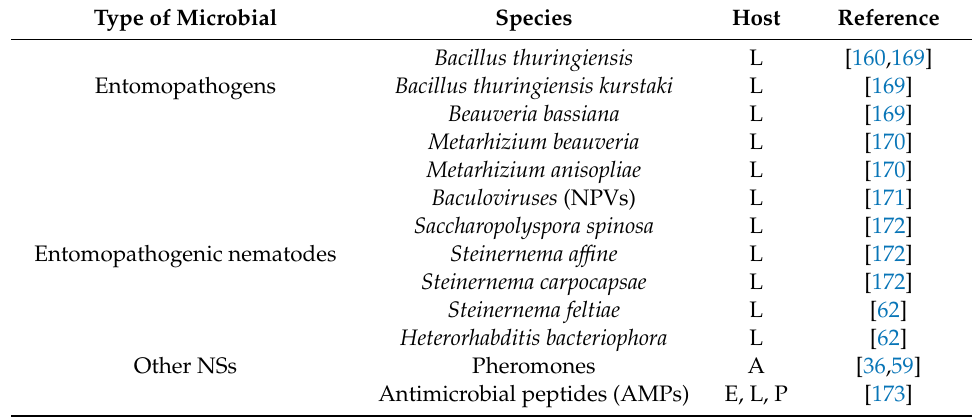
Table 3. Microbials and other natural substances used as biopesticides against Tuta absoluta. (Eggs—E; Larvae—L; Pupa—P; Adults—A). The records were obtained from the literature at the time of writing and may not be purely